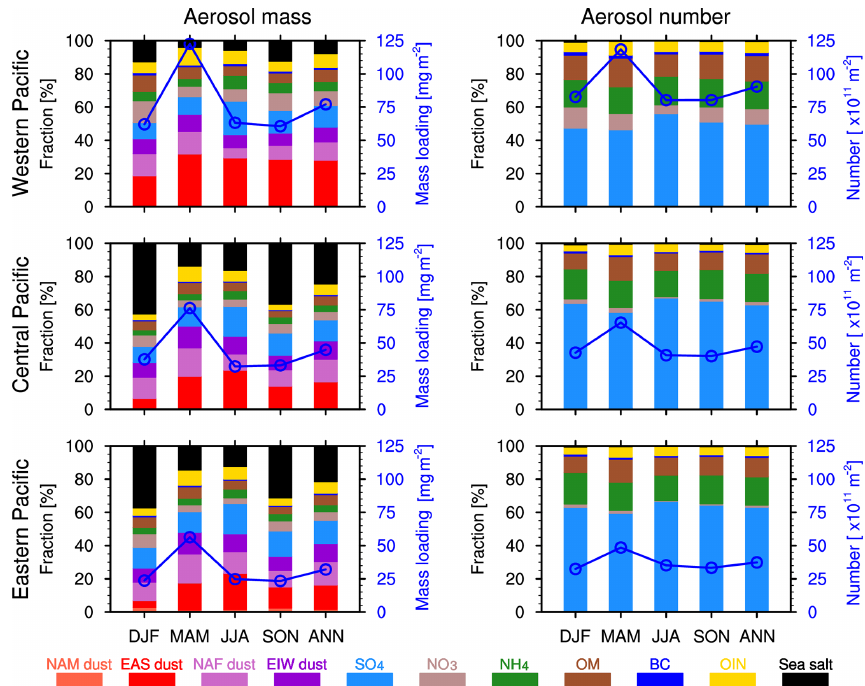
Figure 5. Fractional contributions for seasonal and annual mean aerosol mass and number over the western, central, and eastern Pacific from the WRF-Chem simulation averaged for